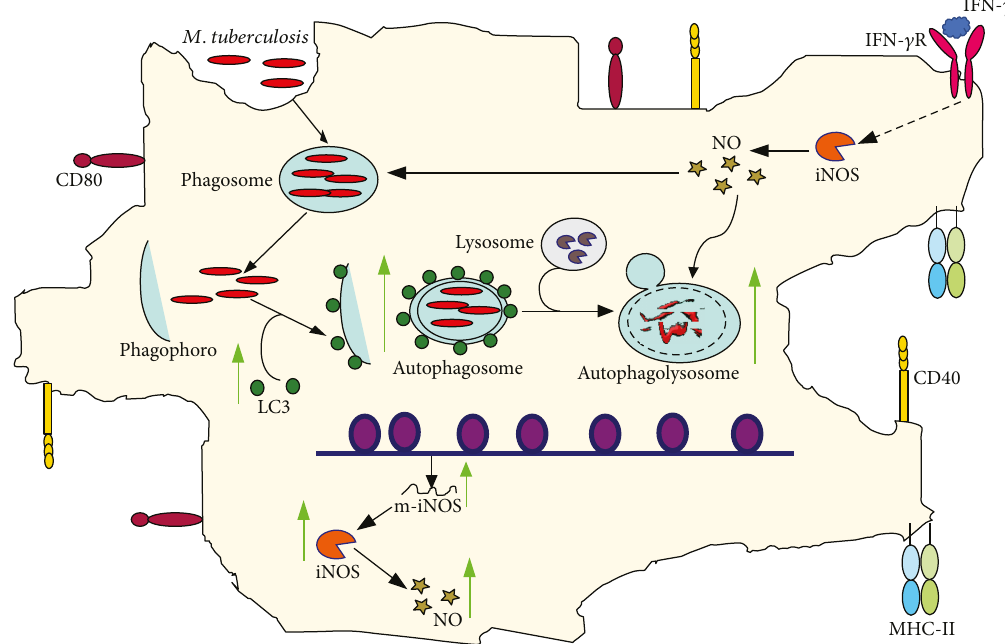
Figure 3: VPA promotes the control of M. tuberculosis infection in macrophages. VPA reduces M. tuberculosis load in infected macrophages through the induction of autophagy and by increasing NO induced by IFN- γ . Green arrows indicate the processes, molecules, or mediators in the signaling pathway that are augmented and/or promoted by VPA. Red arrows indicate processes, molecules, or mediators in the signaling pathway that are inhibited by